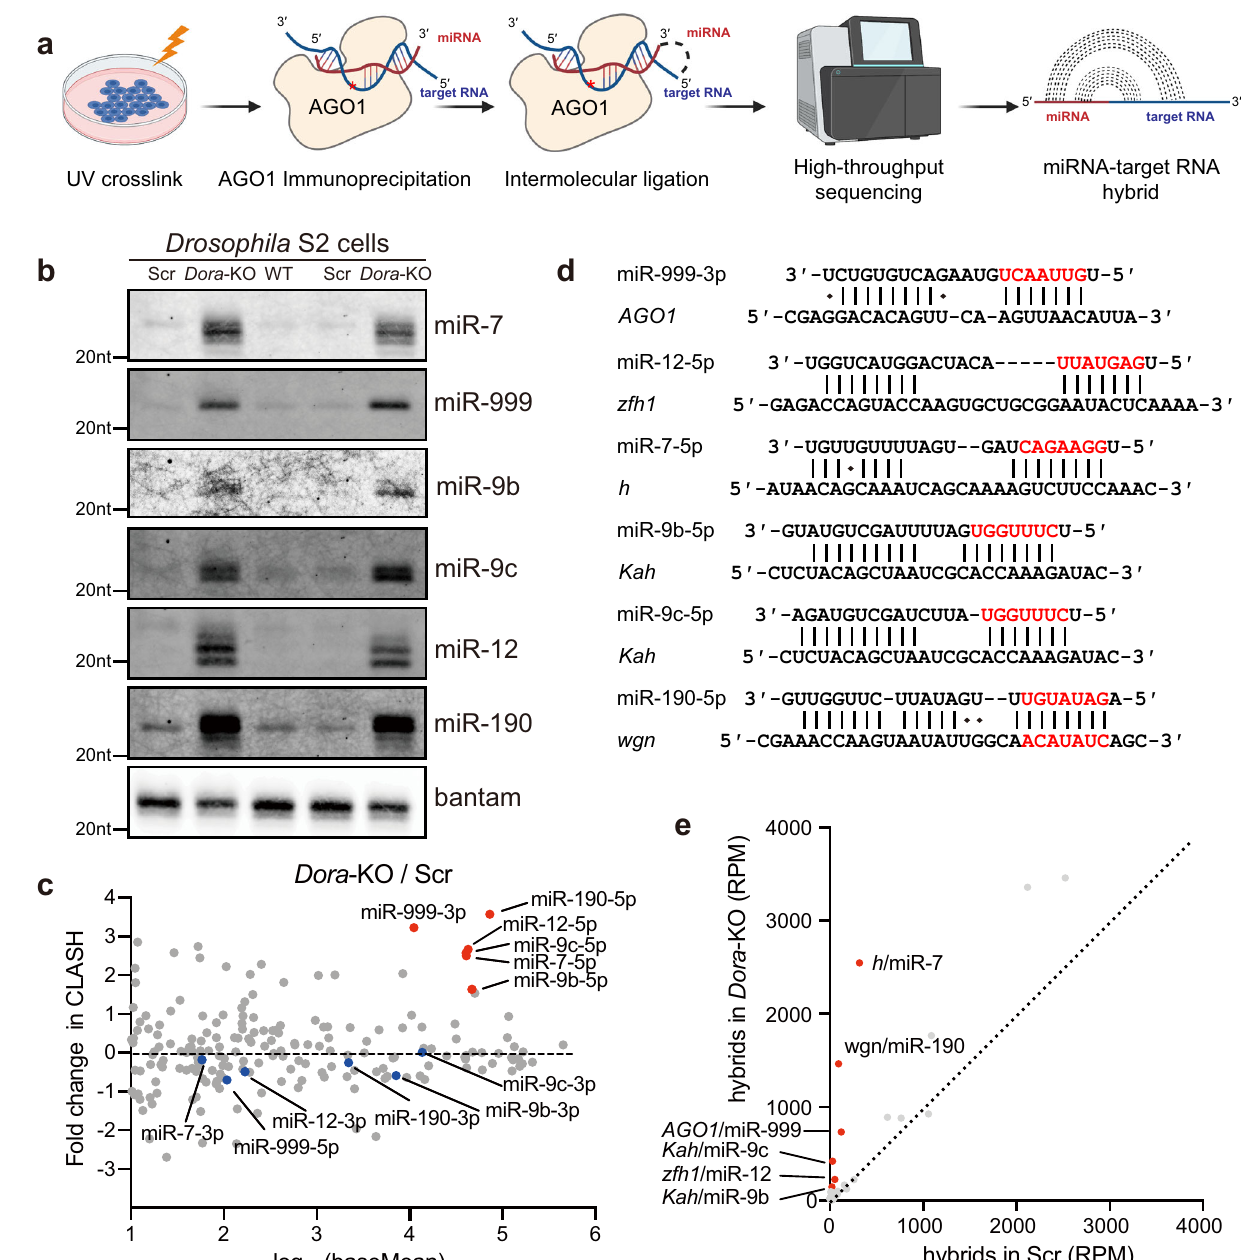
Fig. 1 | Identi fi cation ofTDMD triggers in S2 cells by AGO1-CLASH. a Schematic ofAGO1-CLASH.EndogenousmiRNAsandtargetRNAsarecrosslinked(254nmUV) with AGO1 and immunoprecipitated using AGO1 antibody. After AGO1-IP, the miRNAs are ligated directly to their targets to form hybrid molecules for high- throughput sequencing. Cartoons were created with BioRender.com. b Northern blot analyses of miR-7, miR-999, miR-9b, miR-9c, miR-12, miR-190, and bantam in WT, control-KO (Scramble), and Dora -KO S2 cells. The levels of bantam serve as